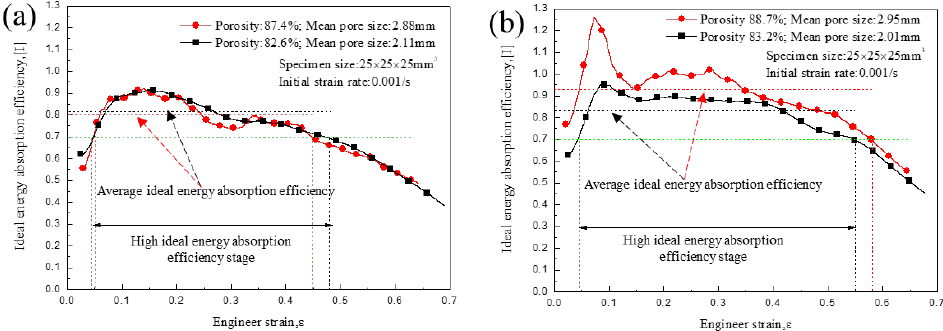
Figure 5. Energy absorption efficiency of aluminum foams: ( a ) Pure aluminum foam; ( b ) 4 wt.% basalt fiber (BF)-containing aluminum foam.